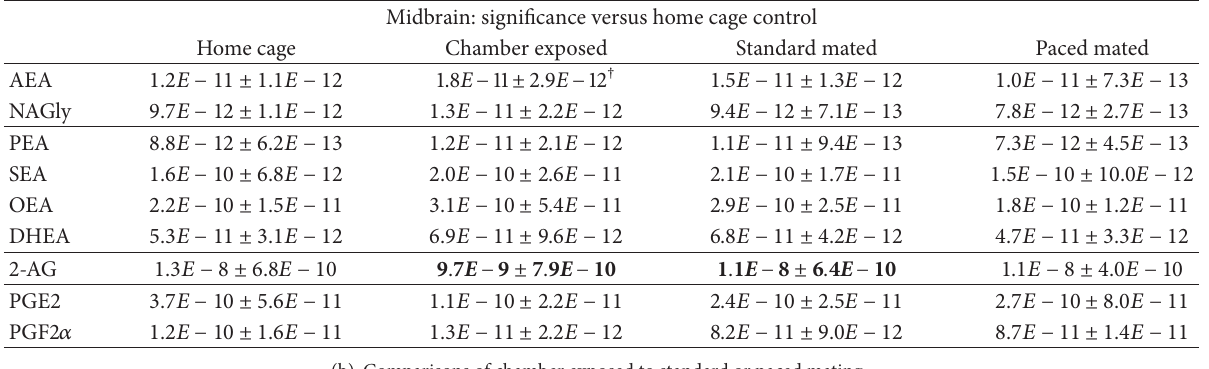
Table 5: Midbrain